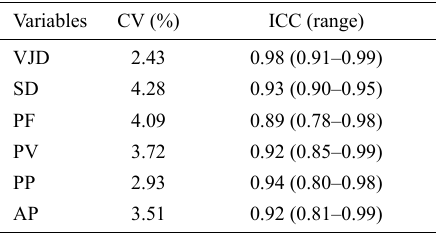
Table 3. During the SJ, the coefficients of variation (CV), intraclass correlation coefficients (ICC), and related 95% confidence limits for variables (n =